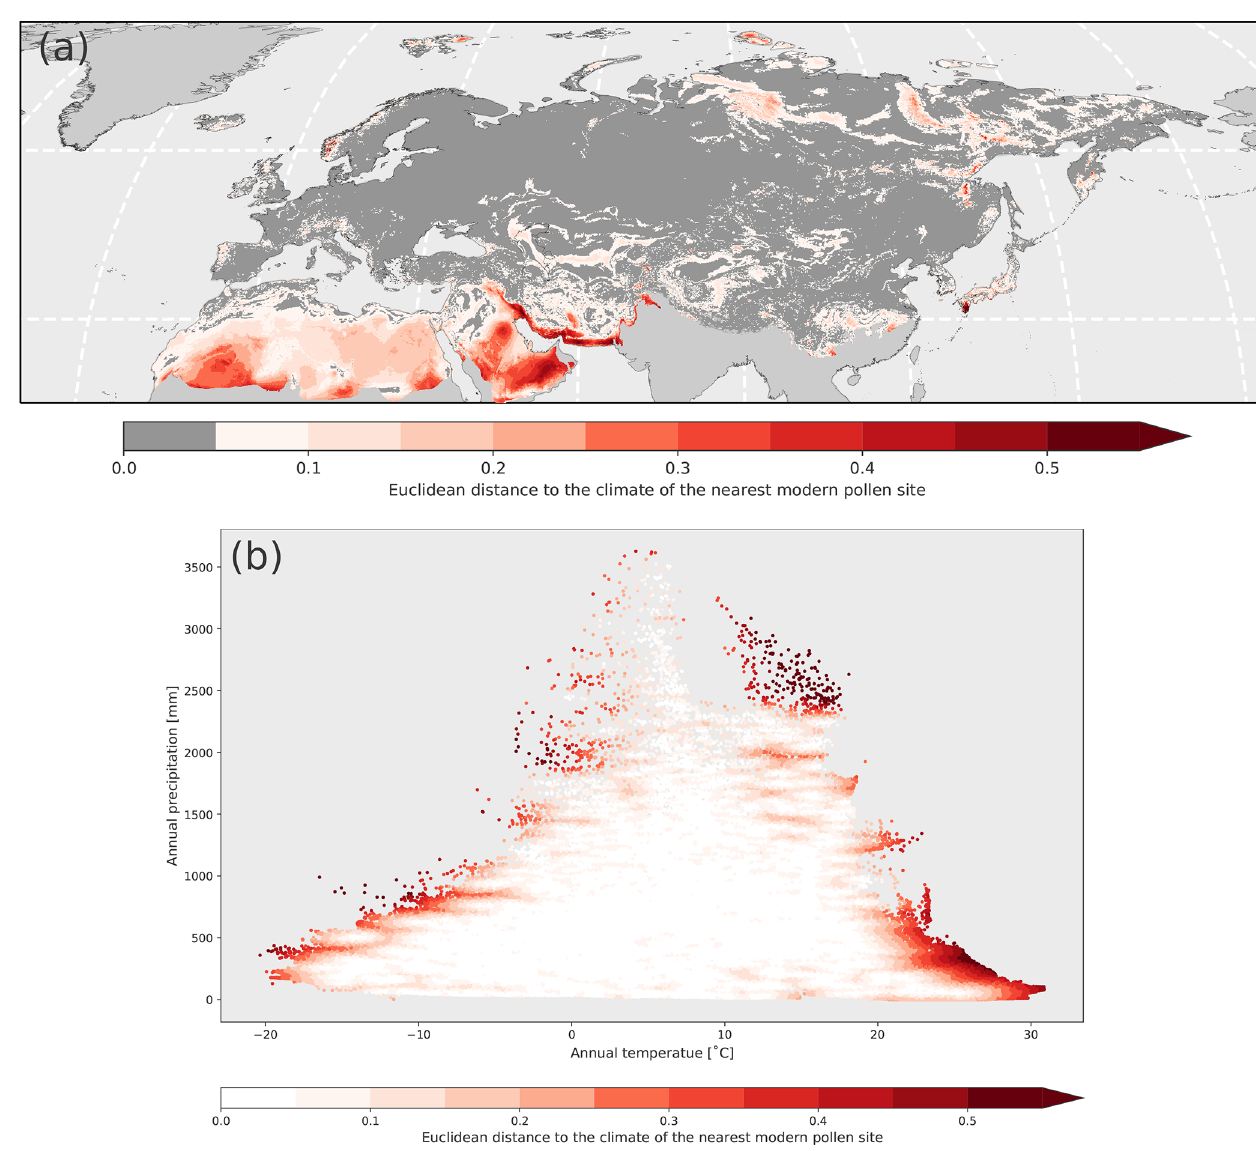
Figure 6. (a) The Euclidian distance between the climate of each modern pollen sample location (as shown in Fig. 3) and the climate of the entire Palearctic region. (b) The same as (a) but shown in climate space. Note that for clarity the values < 0.05 are shown by dark grey in (a) , but white in (b) . The darker the brown shading, the less well that climate is represented amongst the samples. The climate of each pollen site was assigned according to the nearest grid point within the 30s (approximately 1km 2 ) resolution of the WorldClim2 grid, whilst the climate of the region was taken from the grid